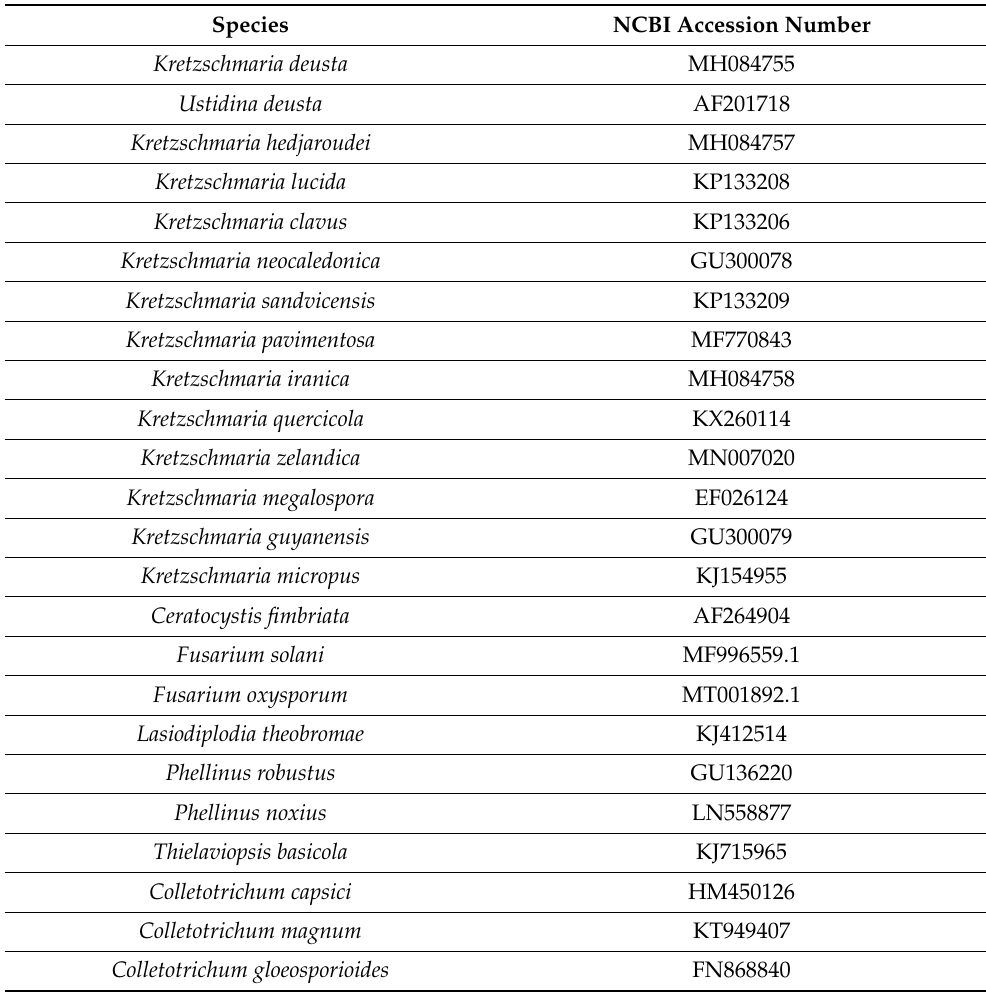
Table 1. List of fungal species and their NCBI sequence accessions, with which the specificity of the primer sets obtained was tested in